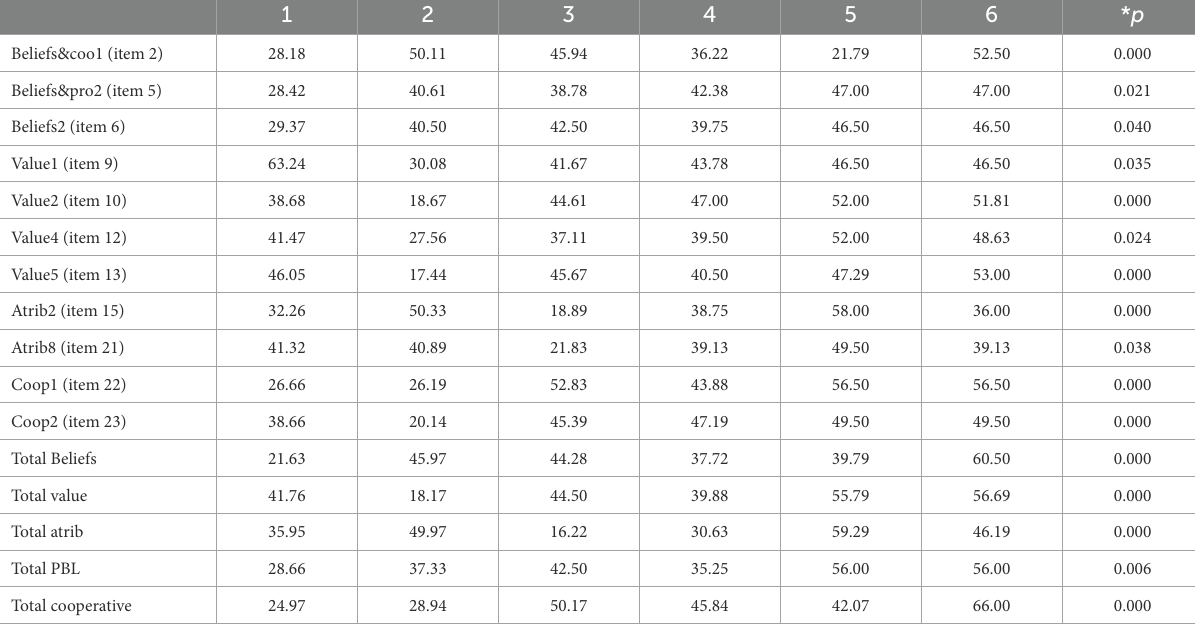
TABLE 7 Kruskal-Wallis analysis to evaluate how motivation depends on class